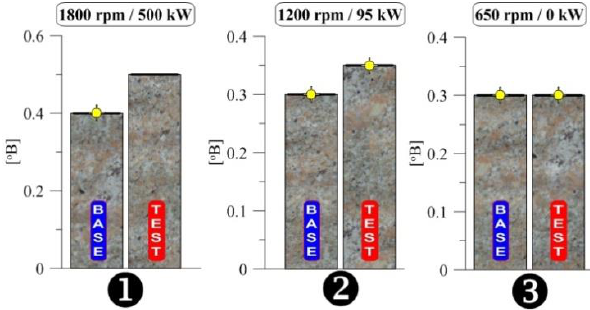
Fig. 20. The degree of the smoke exhaust of the CAT C27 engine powered by the base fuel (BASE) and the base fuel with nitrON ® (TEST), for 3 points of test F (  ) To sum up, in the overall balance of exhaust emissions, the addition of the nitrON ® package to the fuel causes a very large reduction in NO concentration in the exhaust x gas, at the cost of only a slight increase in exhaust